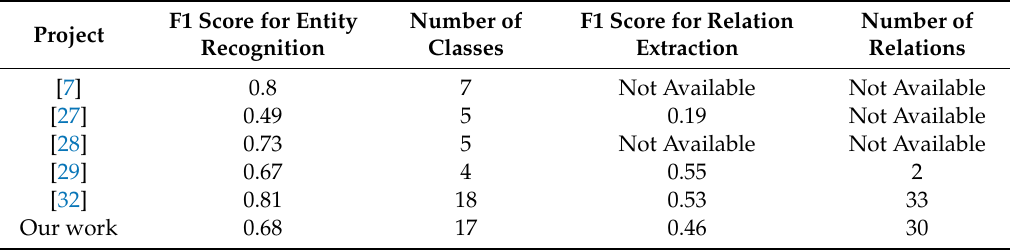
Table 2. Metric performances comparison between our work and other projects.